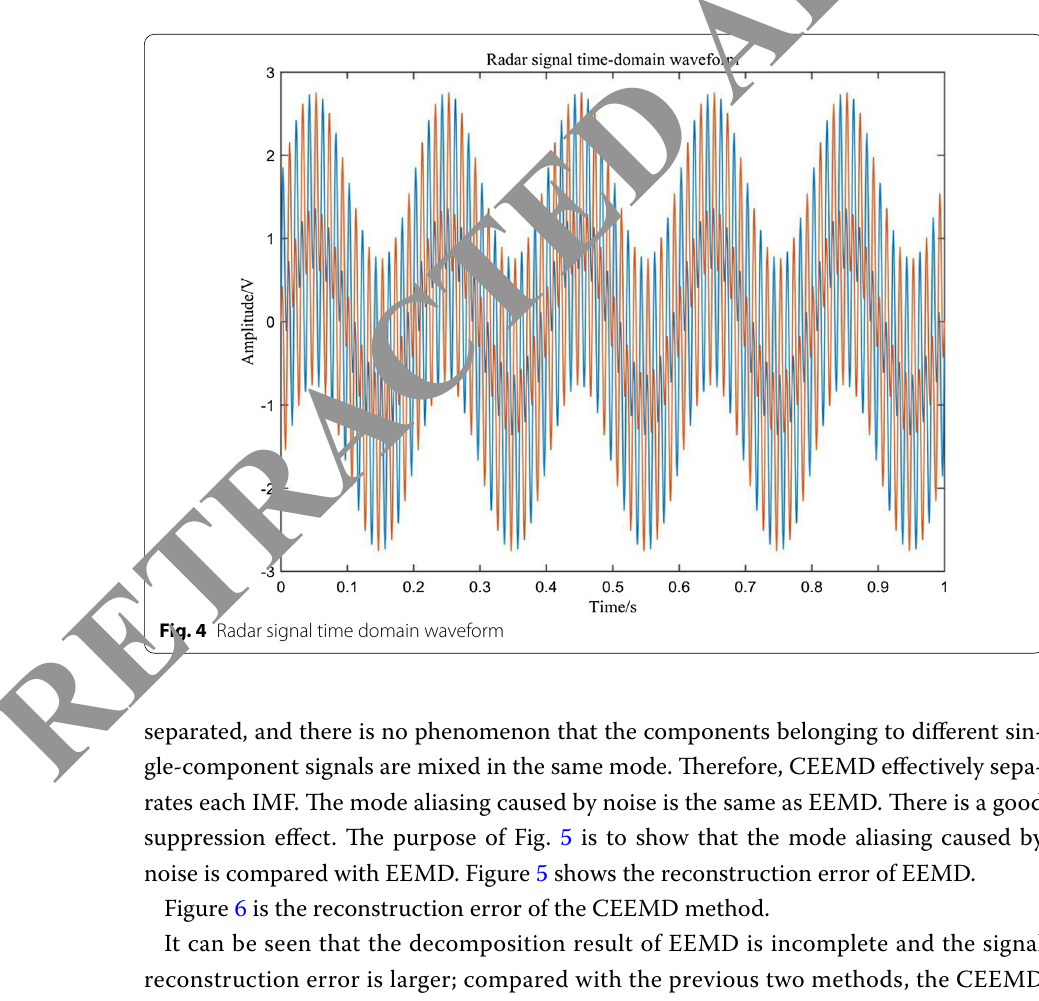
Fig. 3 Radar signal grpdelay